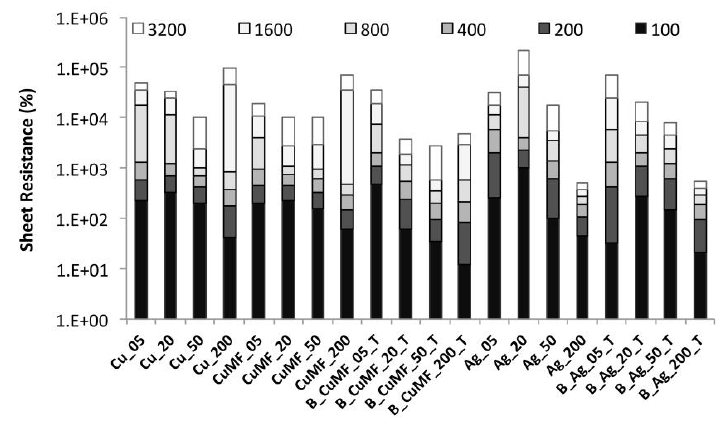
Figure 10. Sheet resistance before and after 100 to 3200 abrasion cycles for the plain and encapsulated